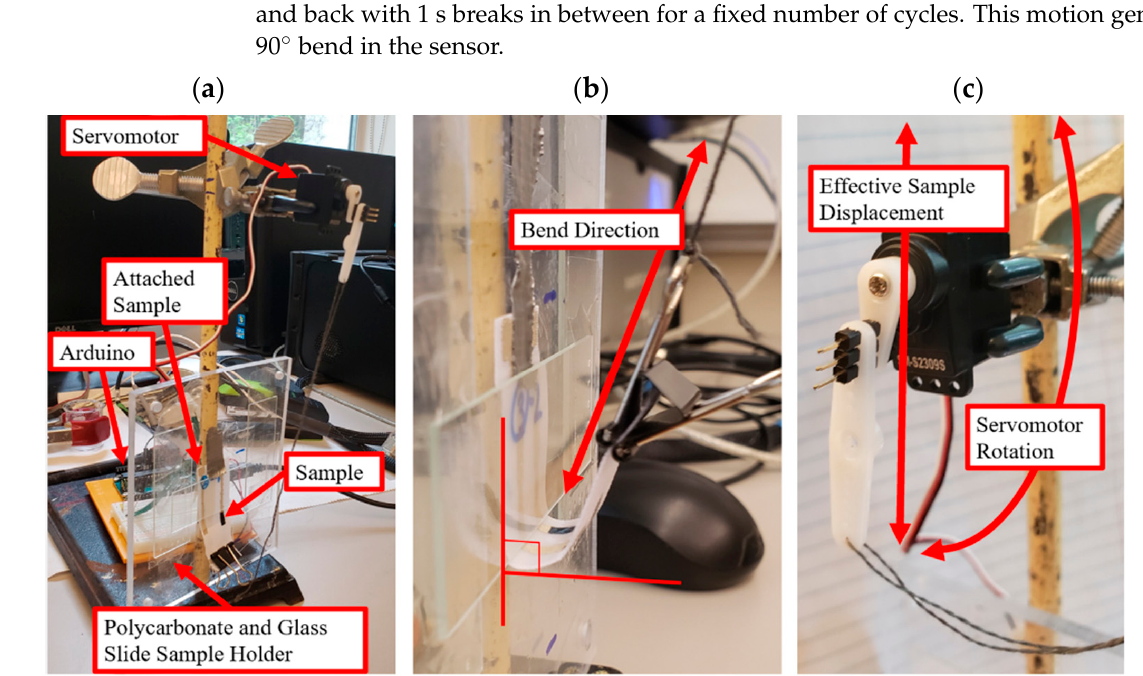
Figure 6. ( a ) Apparatus for effecting multiple bend cycles; ( b ) sample attached to servomotor with binder clip bent to 90° angle; and ( c ) servomotor programmed via Arduino to bend sample.